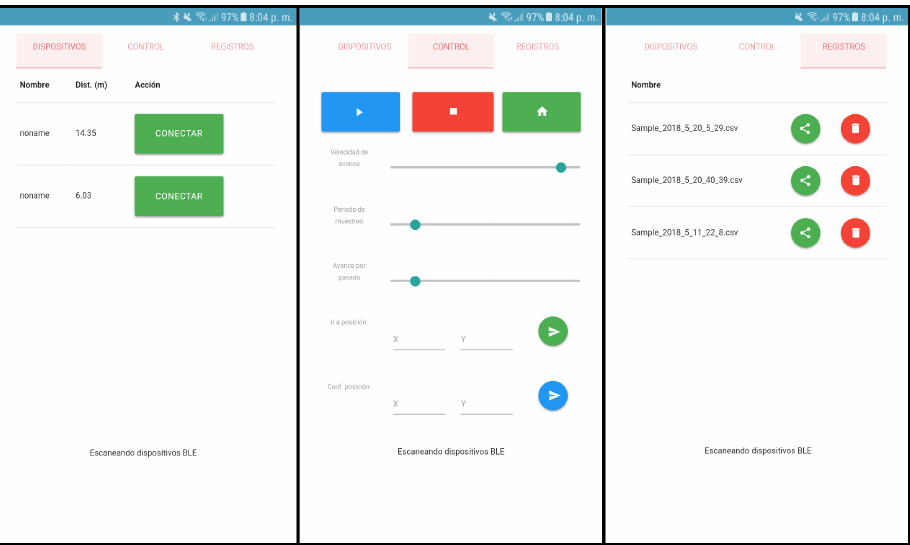
Figure 3. ( a ) Mobile application architecture. ( b ) Web app main class model.